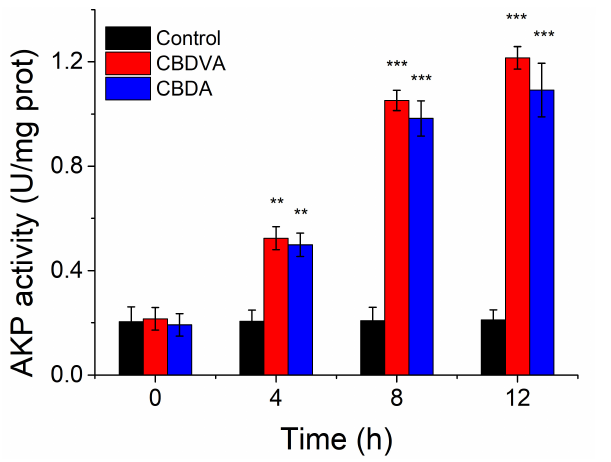
Figure 7. The AKP activities of E. coli in the presence of CBDVA and CBDA at different times. ** p < 0.01, *** p < 0.001 in comparison to control group.